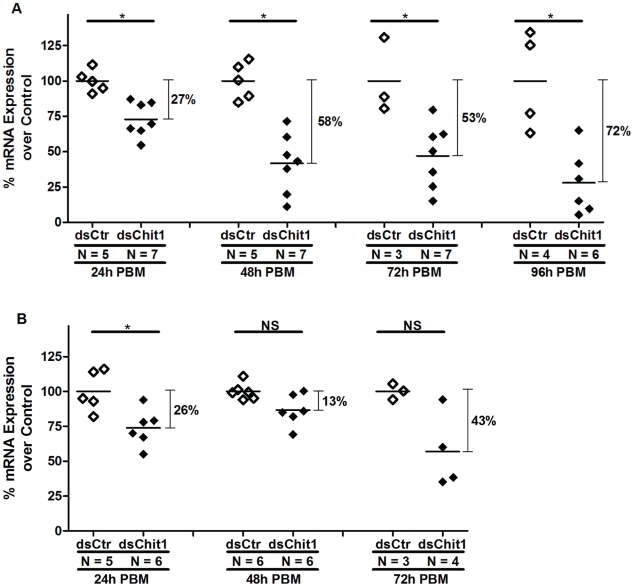
dsRNA effect on PpChit1 RNA levels.Real-Time PCR comparing the mRNA level of PpChit1 between flies injected with 80.5 ng (A) or 144 ng (B) of dsPpChit1 (dsChit1) or dsControl (dsCtr) double-strand RNAs. Significant PpChit1 transcript reduction was exhibited by dsPpChit1 injected flies at 24 h (A and B), 48 h, 72 h, and 96 h PBM (A). PpChit1 mRNA levels were normalized with the S3 housekeeping gene. Results are presented as a percent of PpChit1 expression levels in dsPpChit1 injected flies over the mean of PpChit1 expression levels in dsControl injected flies (considered as 100%) for each time point. The variance in PpChit1 expression in dsControl injected flies is also shown. Each dot represents PpChit1 RNA levels in a single fly. Horizontal bars indicate mean expression level. *: Statistically significant at p<0.05.